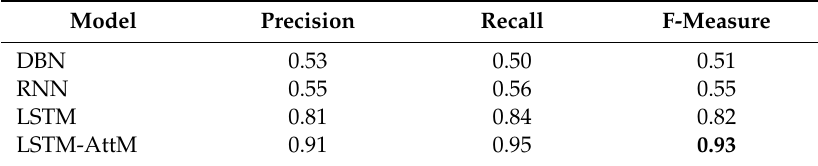
Figure 11. Comparison of precision and recall values for classification of source code with logic errors for ( a ) IS, ( b ) GCD, ( c ) PN, ( d ) BS, and ( e ) SS. Table 8. Average precision, recall, and F-measure values for classification of source code with logic errors.